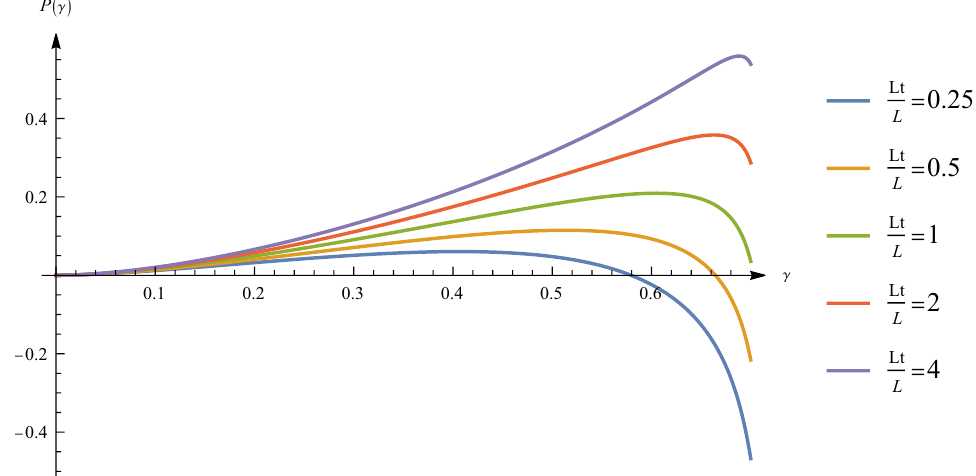
Figure 4 . Plot of the expression defined in eq. (3.108) as a function of γ . Various colors correspond to different choices of ˜ L/L